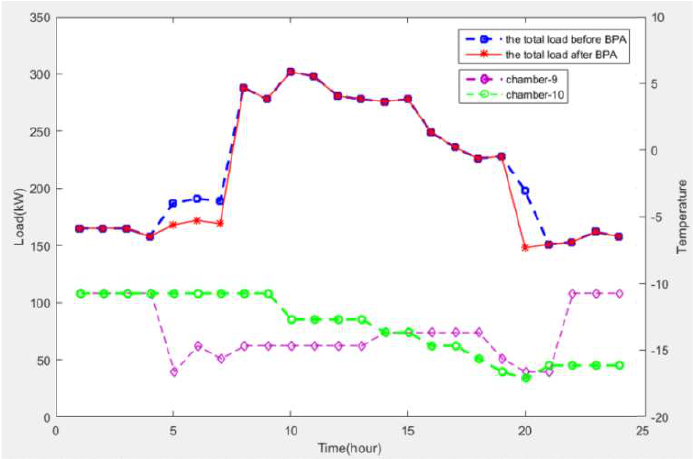
Figure 10. Temperature and load changes of the No. 9 and No. 10 refrigerating chambers.